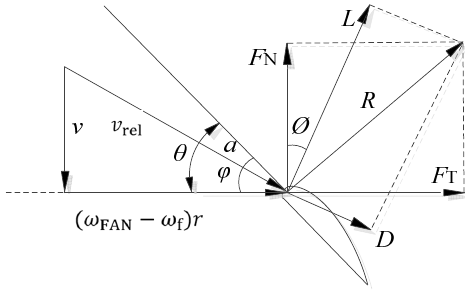
Figure 1. Force of fan blade element.